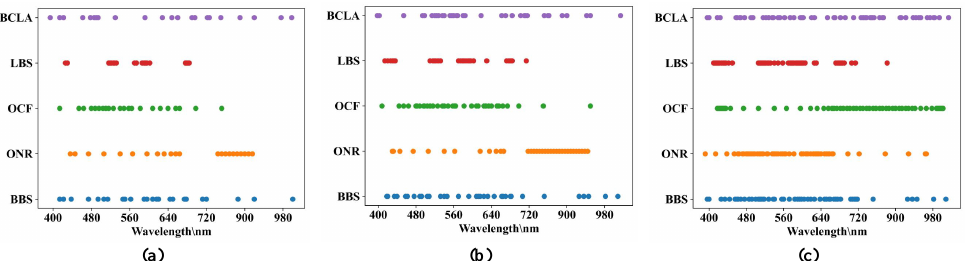
Figure 9. The band selection result with different selected band amounts for the compared band selection methods on the Nano-Hyper data set. ( a ) 22 bands, ( b ) 34 bands, ( c ) 58 bands.